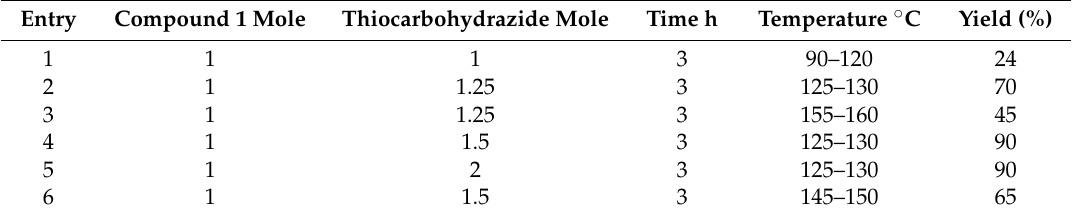
Table 2. Preparation of 4-amino-3-((3,5-di- tert -butyl-4-hydroxybenzylthio)methyl)-1 H -1,2,4-triazole- 5(4 H )-thione ( 3 ).